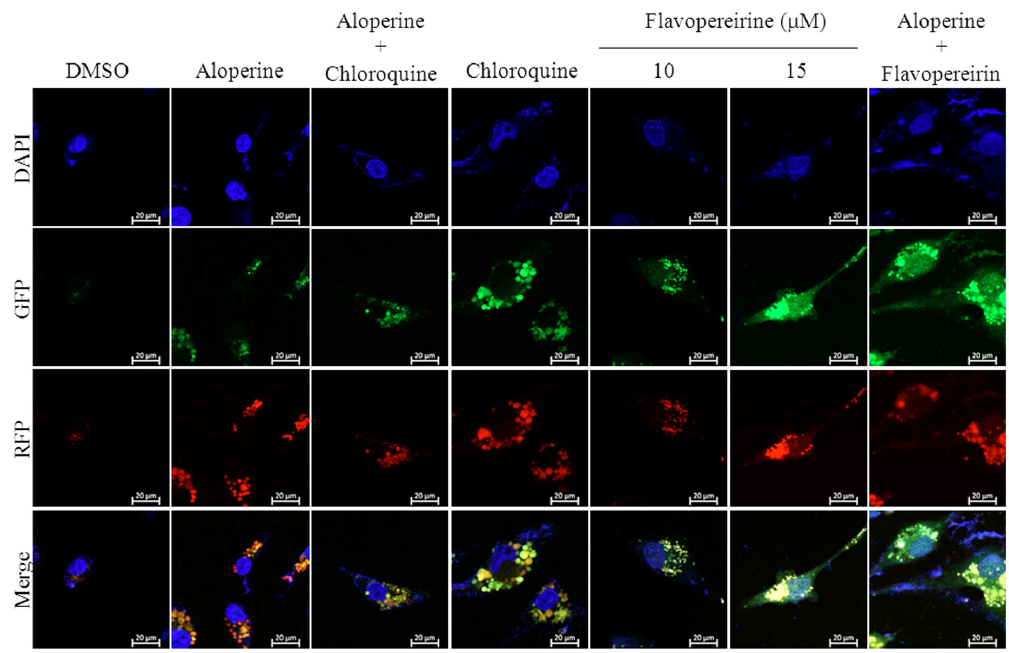
Figure 2. Flavopereirine inhibited autophagic flux in MDA ‐ MB ‐ 231 cells. Representative